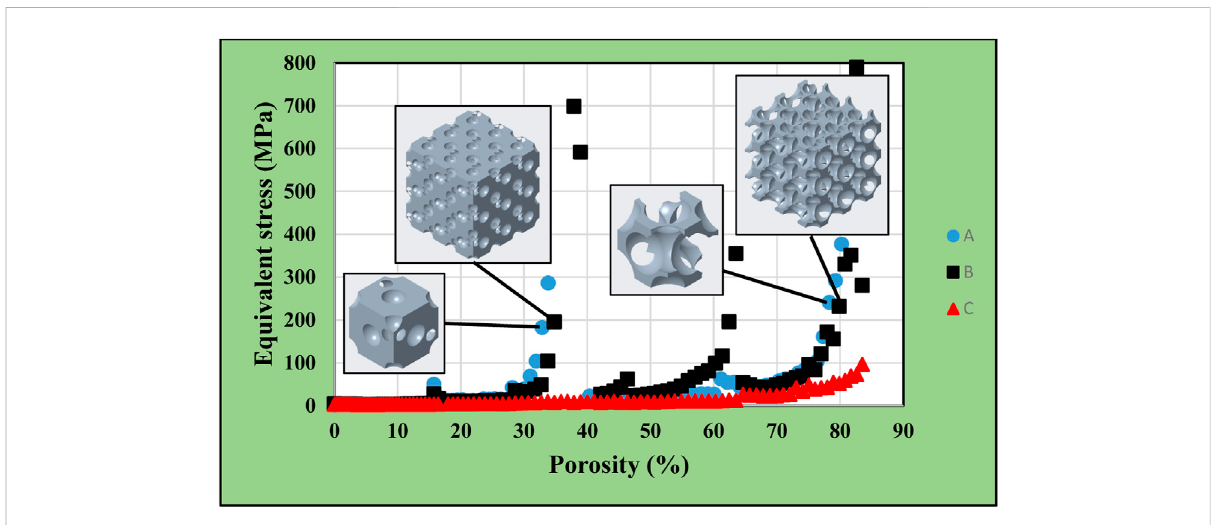
FIGURE 14 Equivalent stress as a function of porosity in simple single-cell and multi-cell structures of diamond-based alignment.